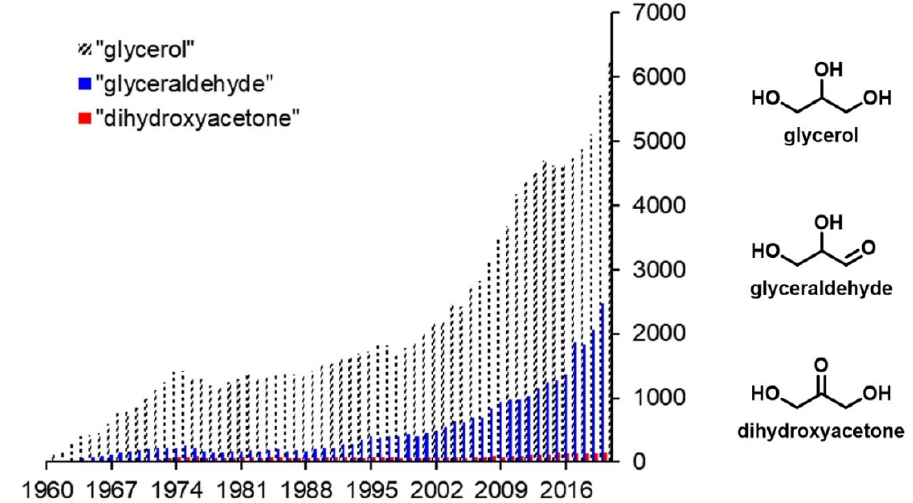
Figure 1. Numbers of publications by year from 1960 to 2021 for dihydroxyacetone and its closest derivatives. Data from Scopus extracted on 4 August 2022.